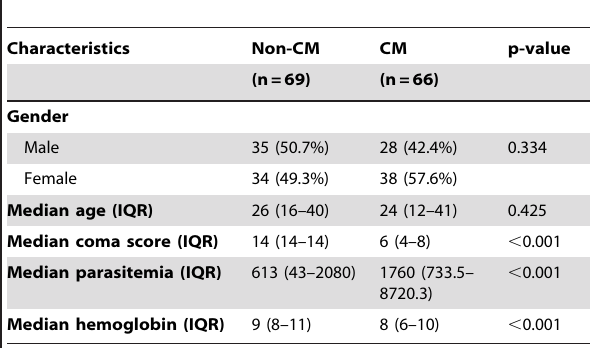
Table 1. Clinical and parasitological characteristics of